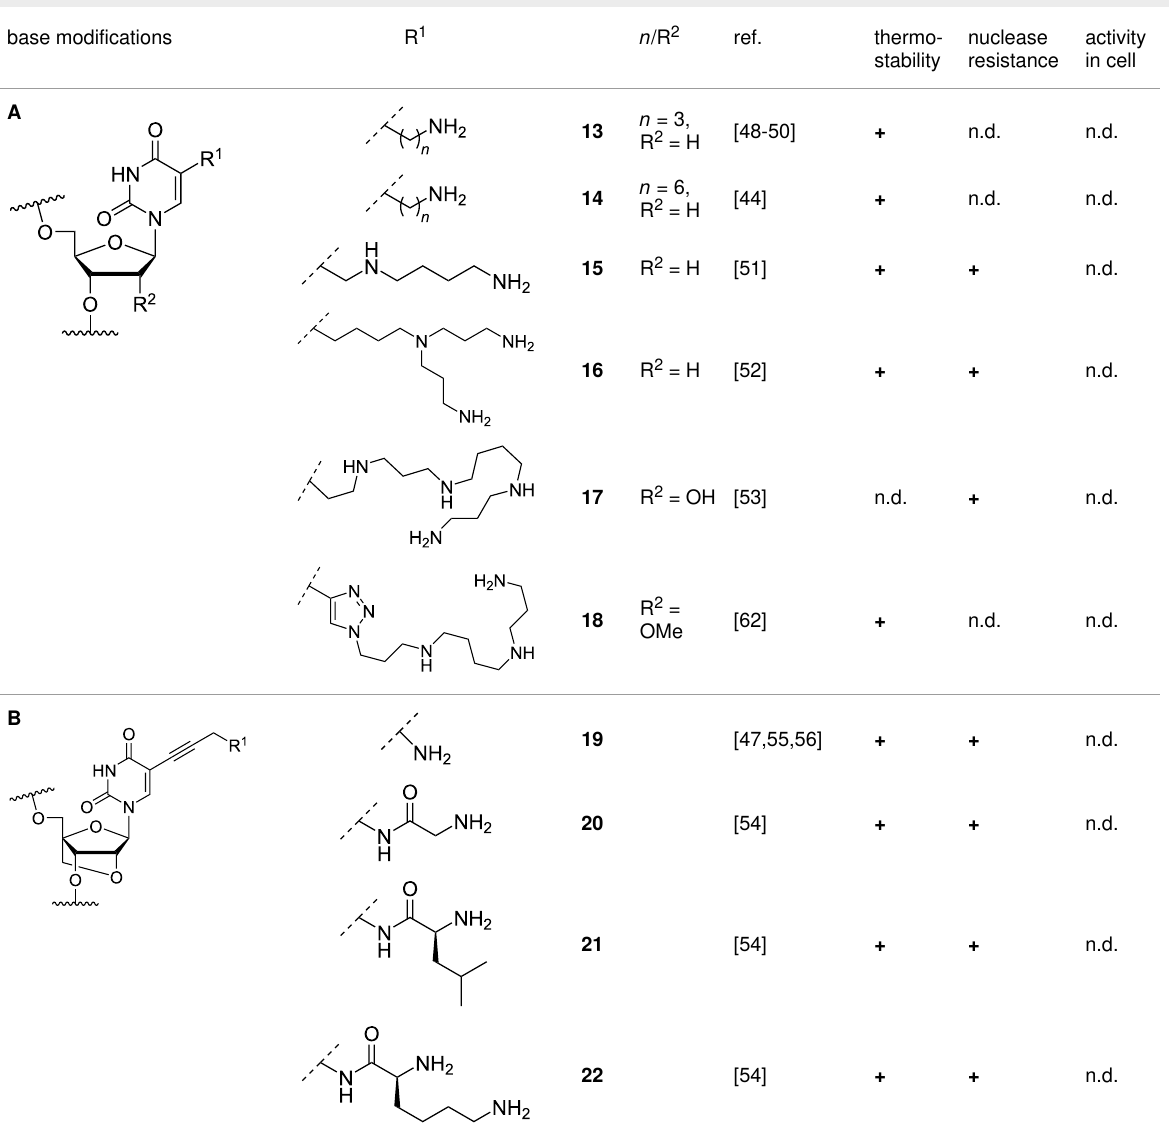
Table 2: Amine-functionalized groups on the nucleobase.